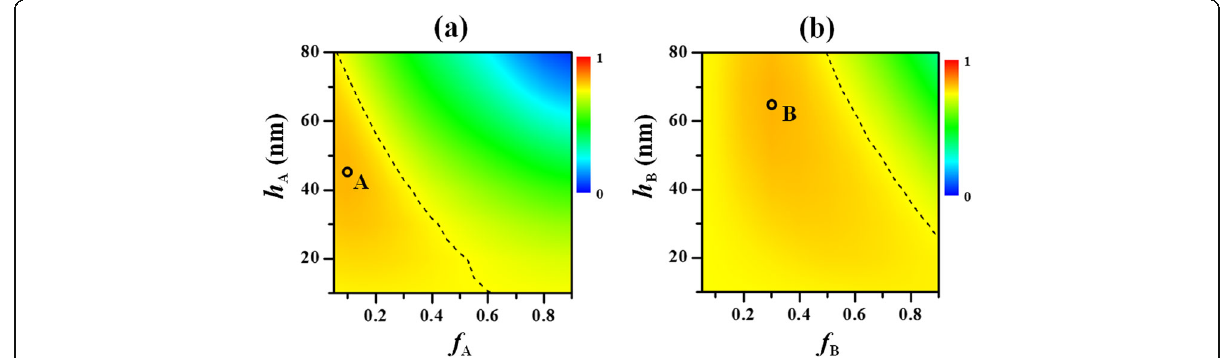
Fig. 2 Maps of the integrated absorption efficiency in the active layer ( η I ) versus the filling and the height of the arrayed patterns in Device A ( a ) and Device B ( b ) when p A (or p B ) = 350 nm. At the denoted point A (with f A = 0.1 and h A = 45 nm) and point B (with f B = 0.3 and h B = 65 nm), Device A and Device B, respectively, produce the optimal η I . The dashed curve represents the contour line of the integrated absorption efficiency equal to that of the planar